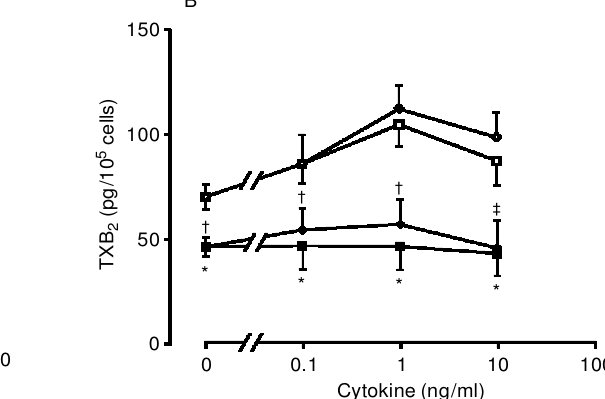
FIG. 5. The effect of the joint incubation with dexamethasone and IL-1 b (squares) or TNF- a (diamonds), for 4 h, on the TXB 2 release. Asterisks indicate the statistical signi® cance to IL-1 b and daggers to TNF- a . In (A) cells were incubated with a ® xed dose of IL-1 b (1 ng / ml) or TNF- a (3 ng / ml) in the absence (0) or presence of several doses of dexamethasone (0.1 ± 100 m M). P , 0.05, P , 0.01, ‡ P , 0.01, compared with the control (100%). n > 6. In (B) cells were incubated with several doses of IL-1 b (0.1 ± 10 ng / ml) or TNF- a (0.1 ± 10 ng / ml) in the absence (open symbols) or presence (® lled symbols) of a ® xed dose of dexamethasone (10 m M). P ,